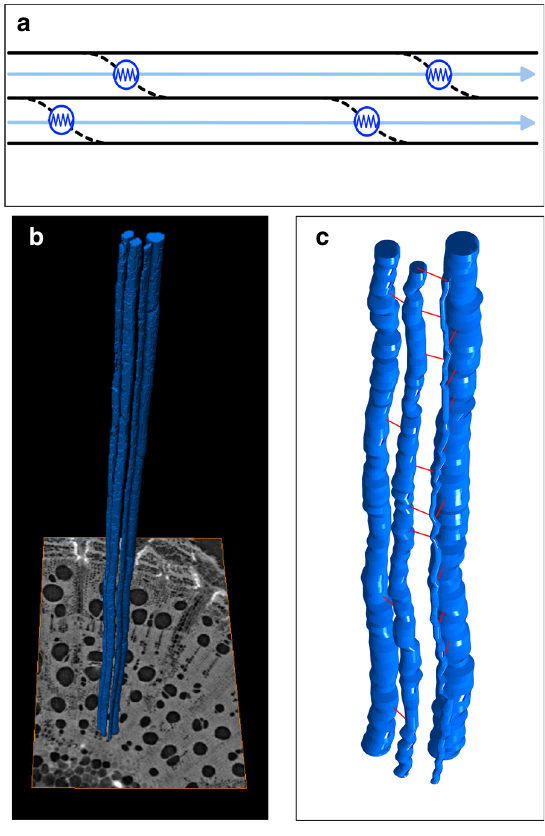
Fig. 1 Idealizations of xylem anatomy vs. networks derived from X-ray micro-computed tomography ( μ CT). a Current working model of xylem simpli fi es the xylem to parallel fi les of conduits of equal length, allowing it to be subdivided into units of one lumen and one end-wall resistance. Successive lumina are connected serially, with no connections across vessel fi les. b Four vessels (blue) segmented from a 3D stack of μ CT images (at base). c Idealization of the same four vessels in the present model: each lumen is represented as circular in cross-section, with radius deduced from the data; connections (red) are placed at the centre of intervals where images show vessels to be